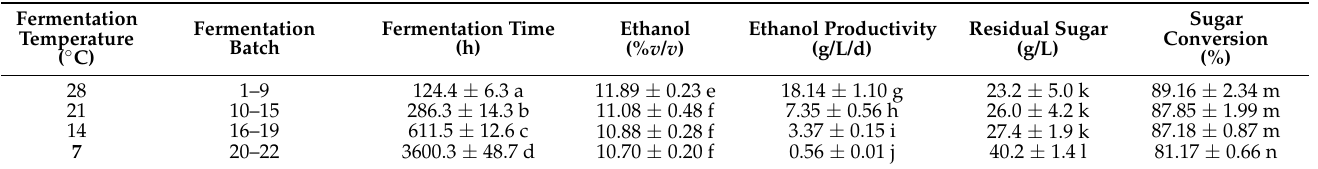
Table 1. Kinetic parameters of must repeated fermentation batches (12.5 ◦ Be) using free cells at 28, 21, 14 and 7 ◦ C.